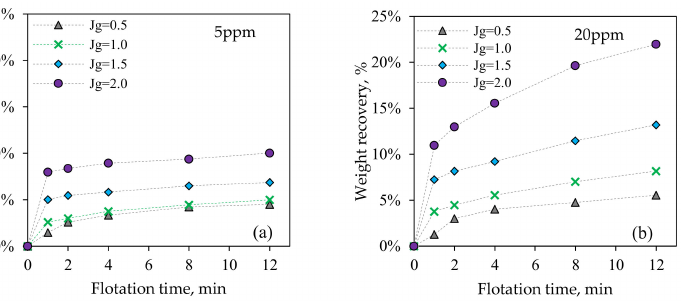
Figure 11. Copper grade-recovery curves for different gas rates and two frother concentrations: ( a ) 5 ppm and ( b ) 20 ppm.